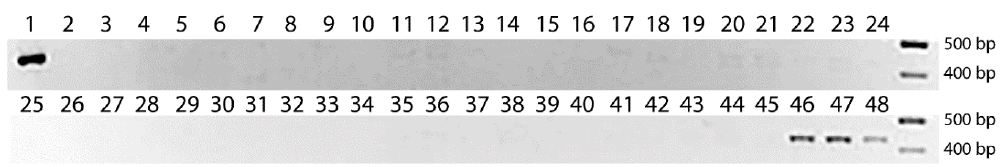
Figure 4. PCR analysis of chromosomal location of Th. elongatum Wx gene-orhtolog using WXTH marker in the series of wheat– Th. elongatum addition lines: 1— Th. elongatum ; 2–8—1E add, 9–19—2E add; 20–26—3E add; 21–32—4E add; 33–39—5E add; 40–45—6E add; 46–48—7E add. 100 bp DNA Ladder (Fermentas) was used as a DNA size marker.